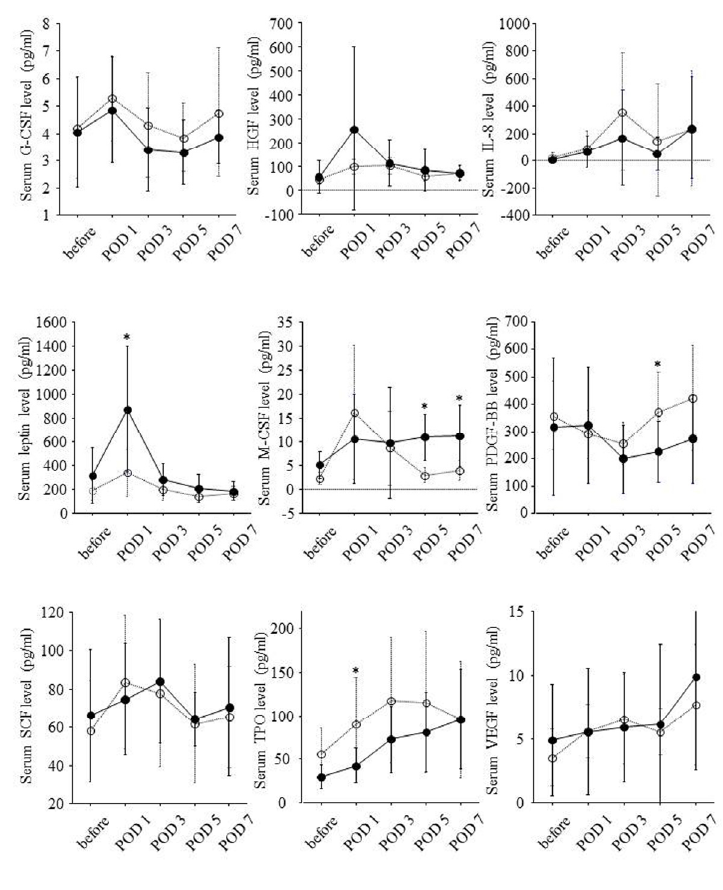
Figure 6. Associations of liver regeneration with serial changes of serum levels of nine growth factors during the clinical course. Solid and dotted lines show serial changes of serum levels of each growth factor in eight patients showing ratio of liver volume on POD 14 to liver volume on POD 0 of 150% or higher and the other eight patients showing this ratio <150%, respectively. Serum levels of each growth factor before hepatectomy and on POD 1, 3, 5 and 7 were expressed as mean ± standard deviation. Before: before